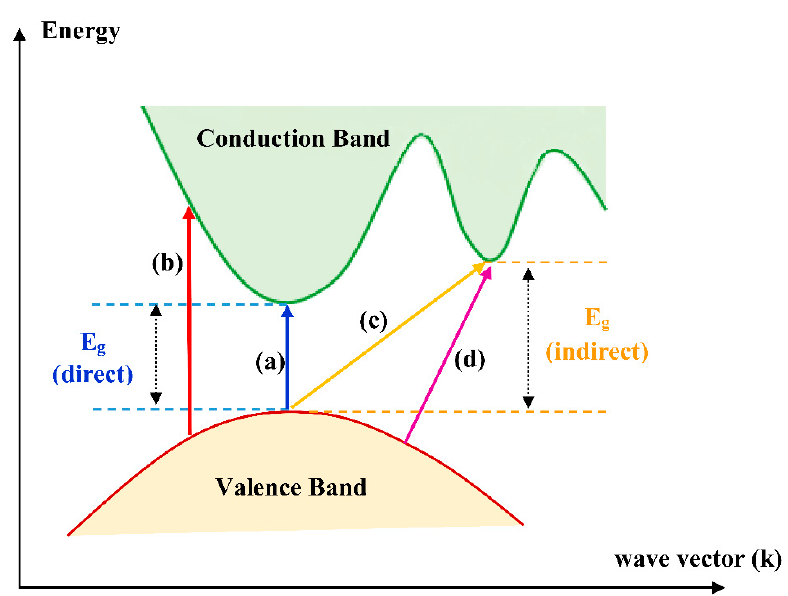
Figure 28. Electronic transition ( a ) allowed direct, ( b ) forbidden direct, ( c ) allowed indirect and ( d ) forbidden indirect [303].